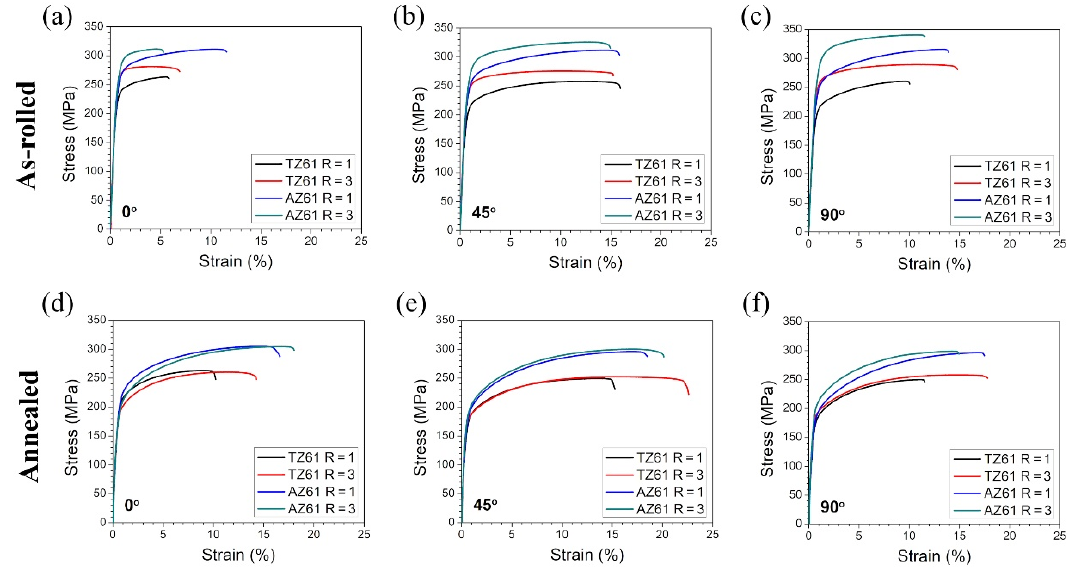
Figure 7. Stress–strain curves for the ( a – c ) as-rolled and ( d – f ) annealed TZ61 and AZ61 sheets processed at speed ratio R = 1 and 3 at different angles to the RD: ( a , d ) 0°, ( b , e ) 45°, and ( c , f ) 90°.